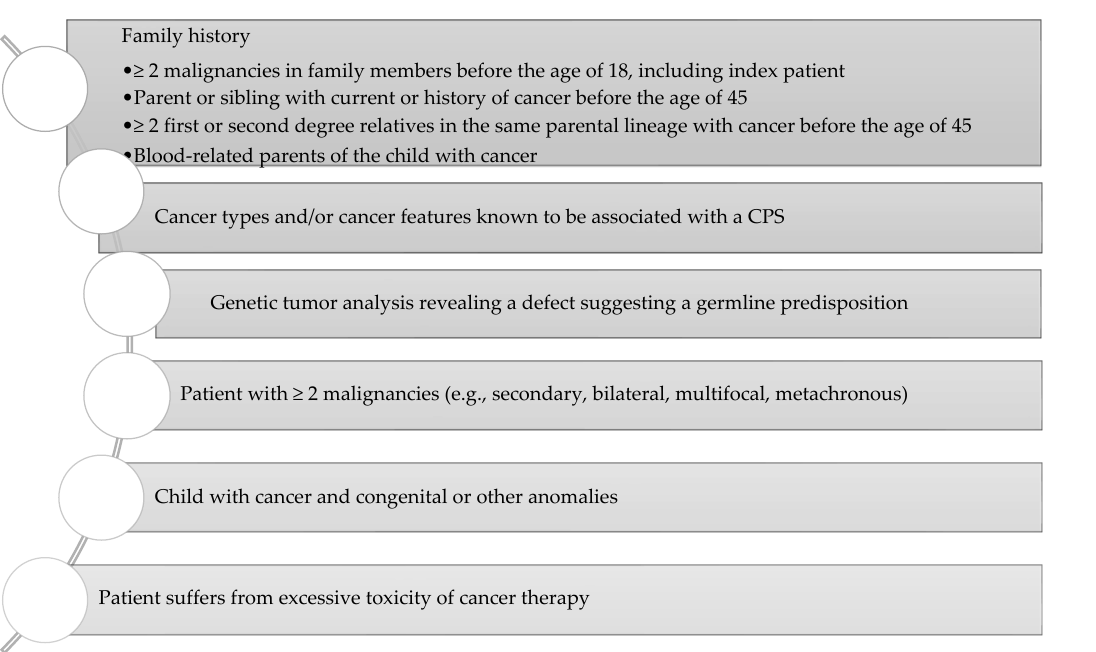
Figure 2. Consideration of a possibility of CPS diagnosis. Adapted from Ripperger et al., 2016